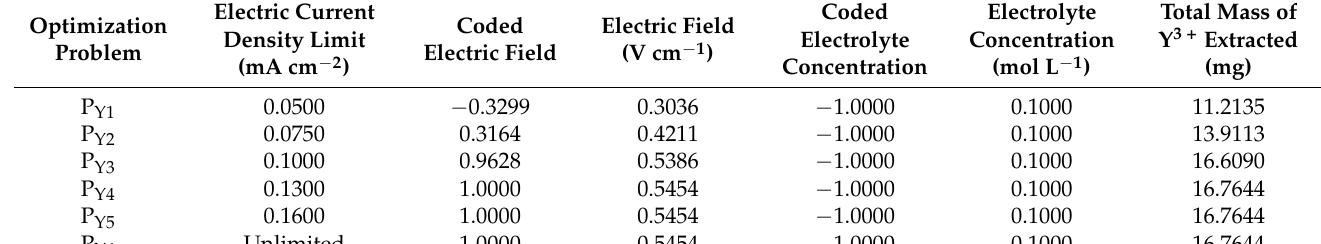
Table 4. Optimal configurations considering different limits for electric current density.